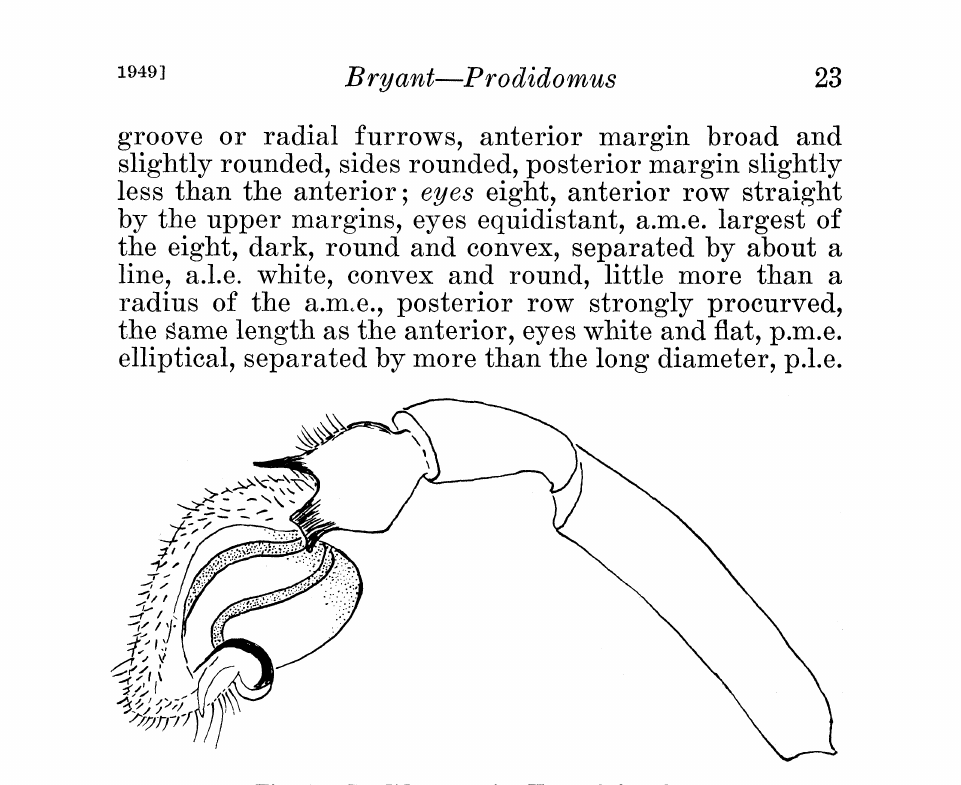
Fig. 1. Procidomus rlus Hentz le2t